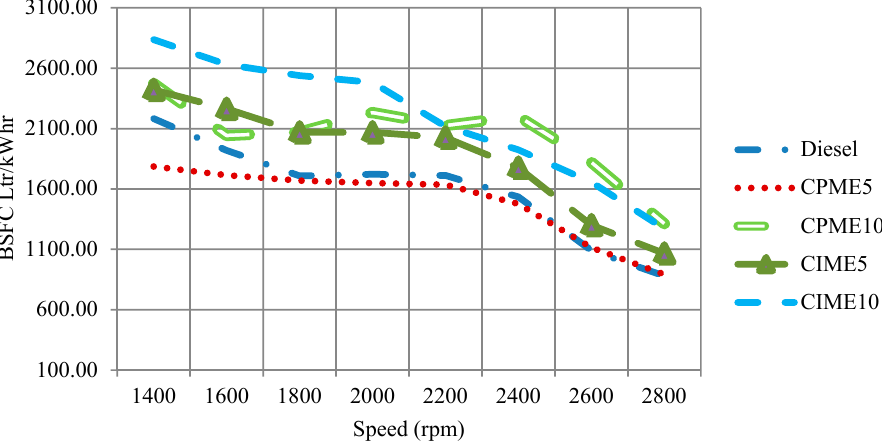
Figure 1. Changes in Brake Specific Fuel Consumption (BSFC) of diesel, CPME, and CIME blends with speeds.